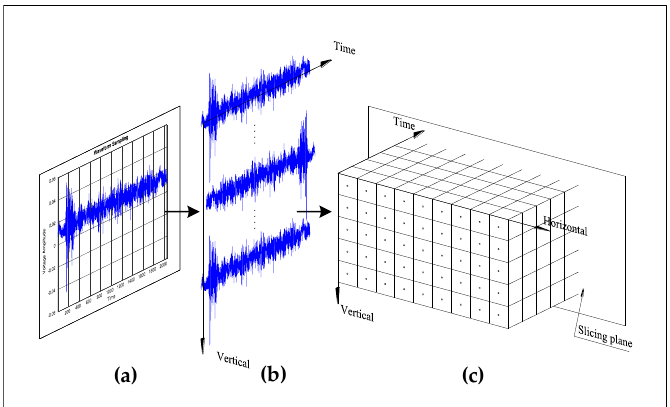
Figure 4. Process of ultrasonic wave propagation imaging (UWPI) system. ( a ) Measurement of time-domain response at each impinging point. ( b ) Placement of the measured signals at their corresponding laser impinging points that are outlined at the image processor. The result is a vertical plane containing all the impinging points and an into-the-page axis representing the time axis. ( c ) Slicing along the time axis of the 3D